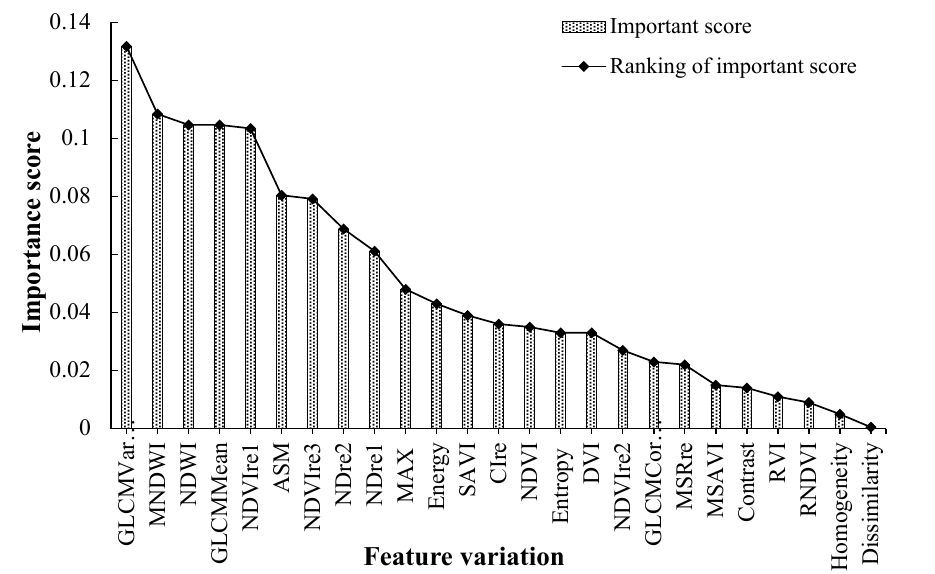
Figure 3. The importance scores and rankings of different feature variables in 2021.